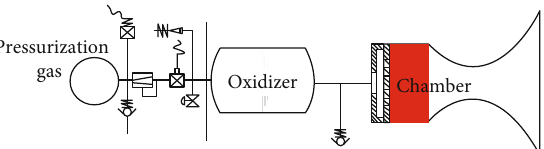
Figure 1: Framework of the HRM working